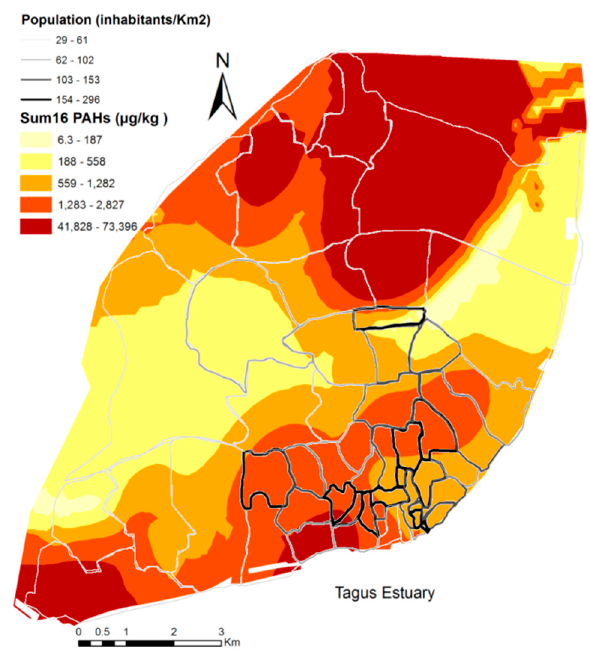
Figure 6. Contour map interpolated by ordinary kriging for the cancer risks considering a residential land use; the class limits correspond to the risk limits suggested by different guidelines. The map also shows the 53 districts of the city and their population density.